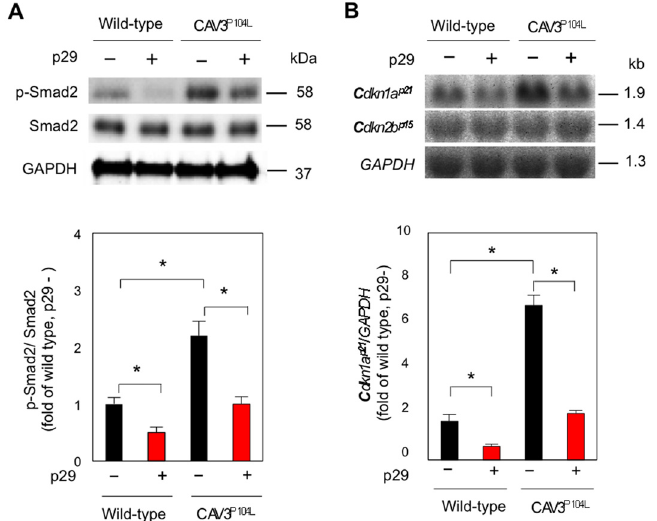
Fig 9. p29 inhibits activation of intramuscular myostatin signaling in caveolin 3-deficient LGMD1C model mice. Immunoblot ( n = 5). ( A ) and northern blot ( n = 7). ( B ) analyses of TA muscles treated with or without p29 ( upper ). Densitometric analyses ( lower ). Values are mean ± SD fold increases compared with untreated wild-type muscles. * P <